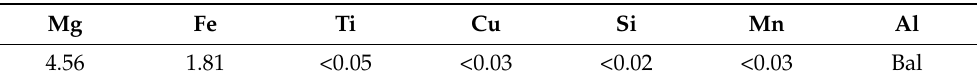
Table 1. The chemical compositions of alloys investigated in the experiment